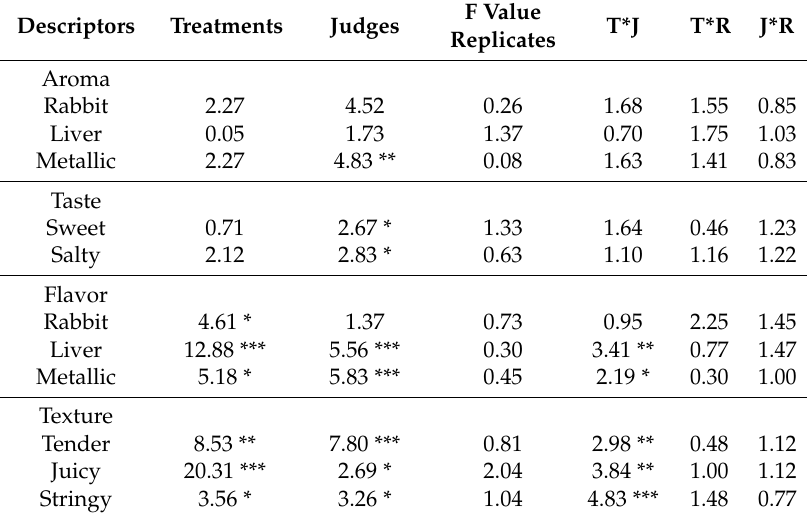
Table 6. The F value and statistical significance of treatments (C, SP1, SP2) and their interaction for sensory descriptors of Longissumus lumborum muscle, where the number of judges, n = 8, and the number of replicates, n = 3.